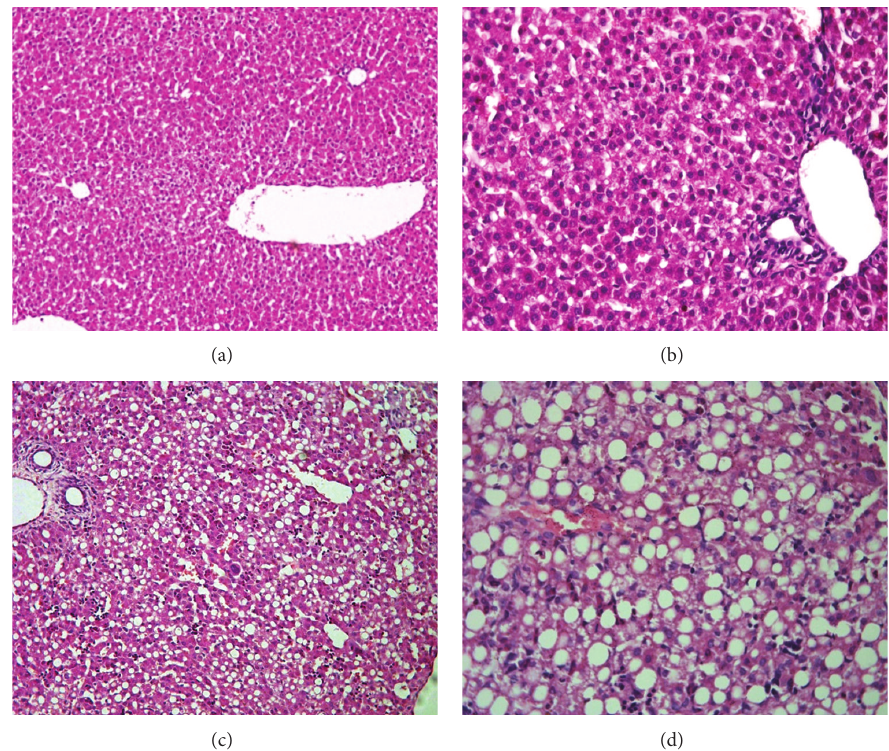
Figure 2: Representative sections of livers from the TPN and control groups obtained on d 7 and stained with H and E. Note: (a) control group, 200x; (b) control group, 400x; (c) TPN group, 200x; and (d) TPN group, 400x.